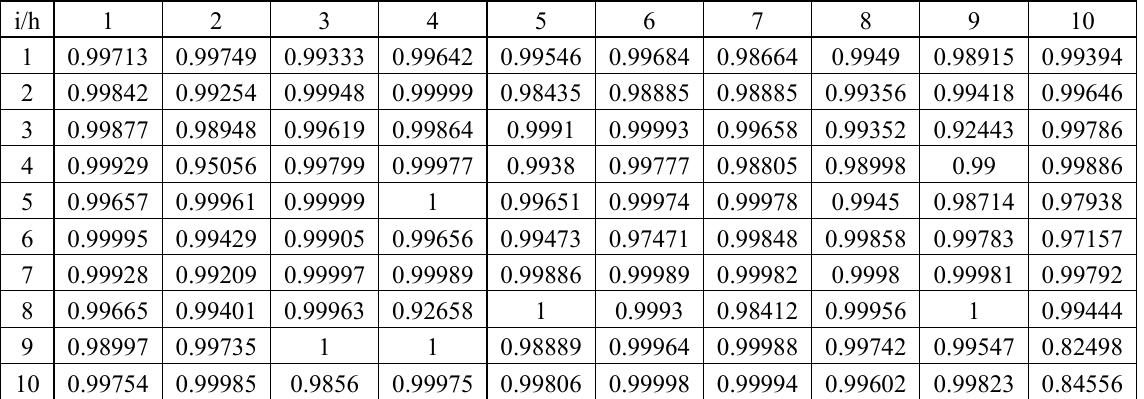
Table 2. TDNN topology regression performance (i = nodes in the tapped delay line, h = nodes in the hidden layer).